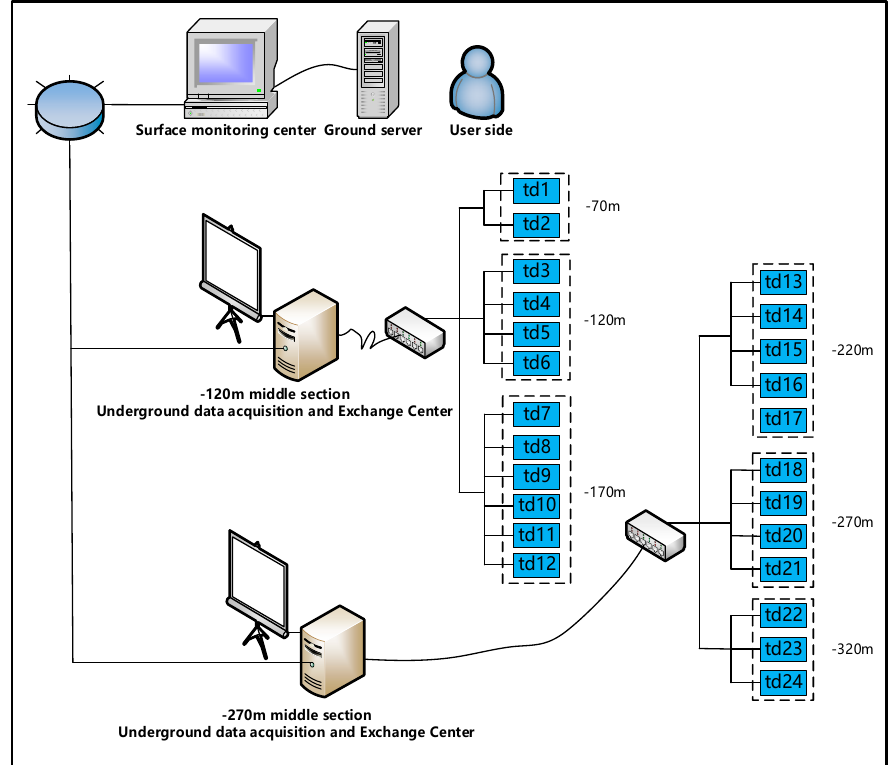
Figure 1. Framework diagram of mine acoustic emission remote monitoring system. ( − 120 m represents 120 m below the local datum level of the mine and − 270 m represents 270 m below the local datum level of the mine.).